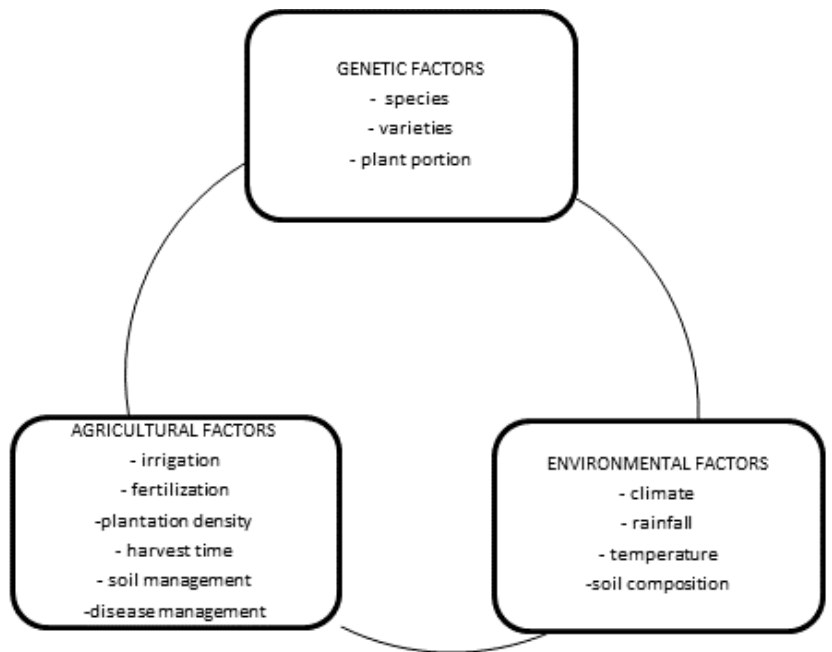
Figure 1. Factors that influence the quality of the final product.